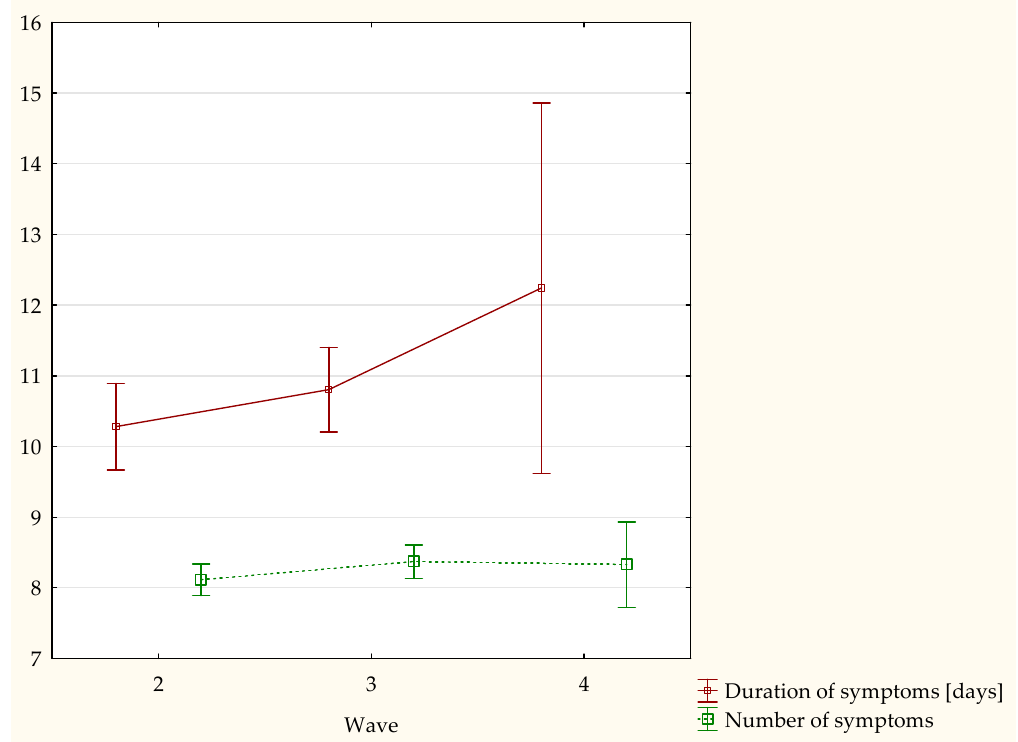
Figure 2. Comparison of the time of symptom duration and number of symptoms in reference to the respective stages of the study.